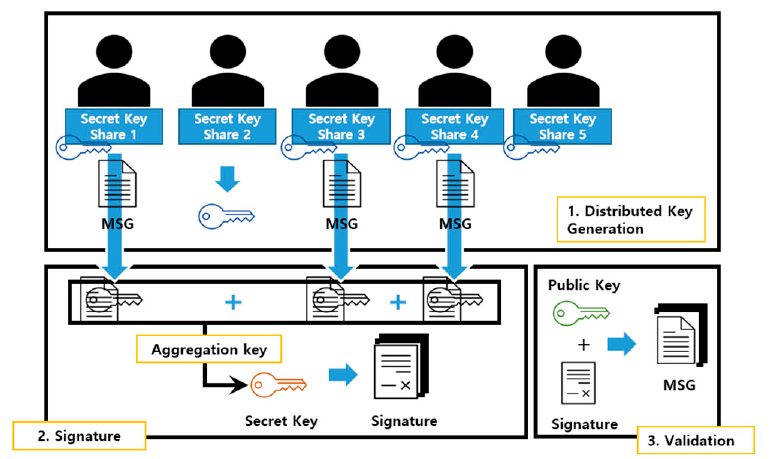
Figure 5. FROST signature